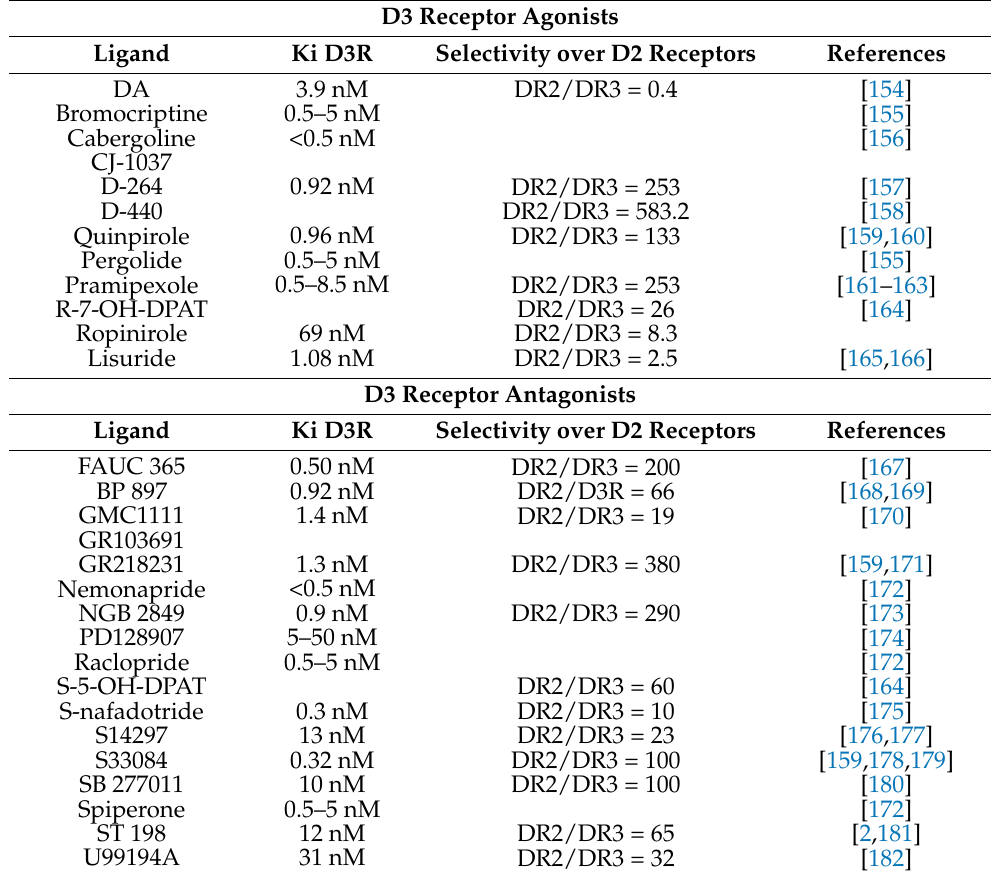
Table 1. Some D3 receptor-selective agonists and antagonists according to their Ki and their selectivity over D2